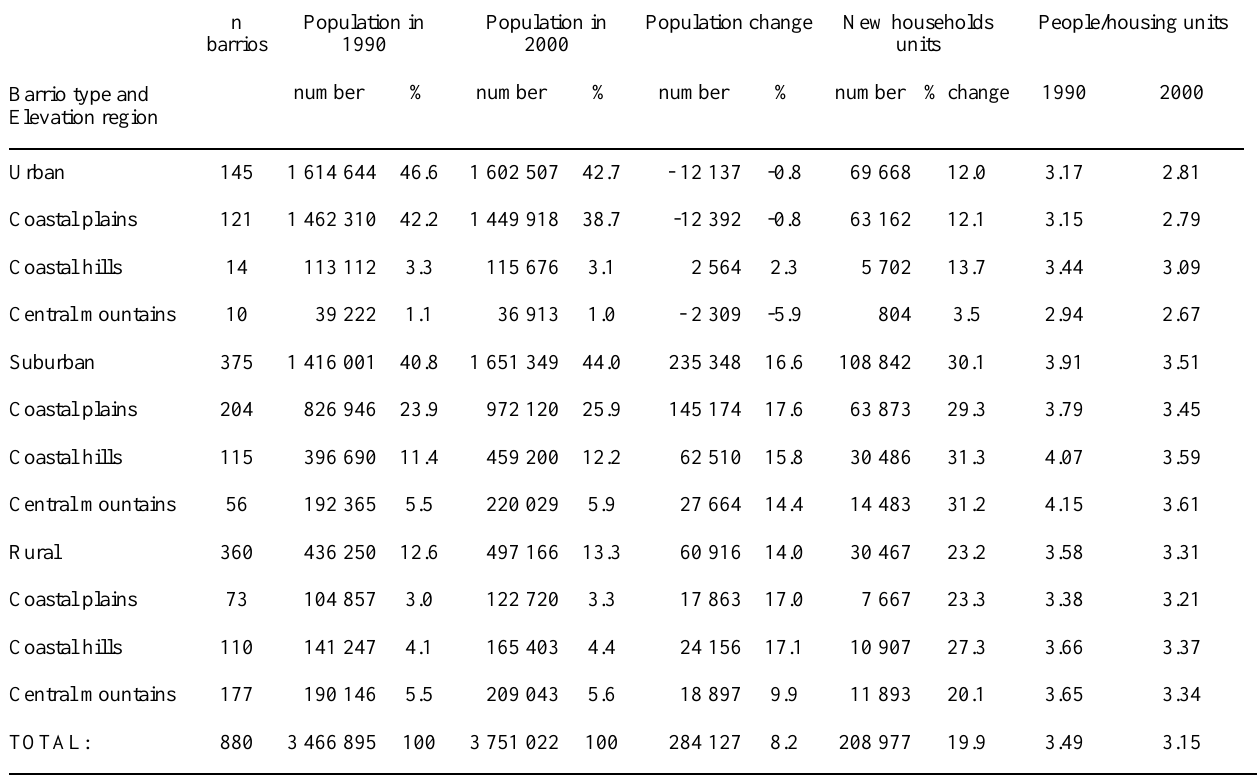
n Population in barrios 1990